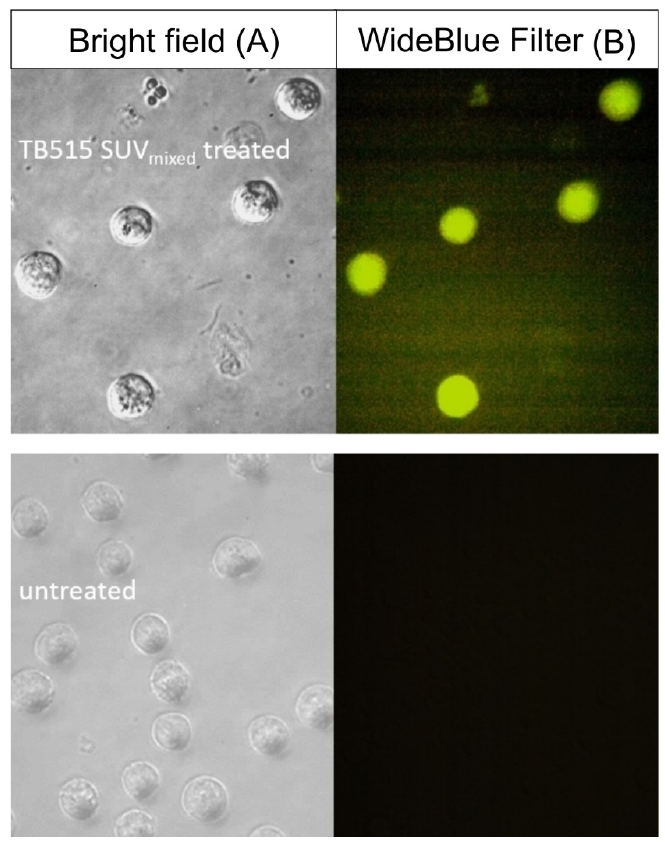
Figure 4. Internalization of TB515 antitubercular compound encapsulated in SUV mixed by MonoMac- 6 human monocytic cells captured by fluorescence microscopy. Column ( A ) displays bright-field images of untreated control cells and treated cells (c = 25 μM; 3 h) Column ( B ) displays untreated and treated cells (c = 25 μM; 3 h) imaged with WideBlue Filter.